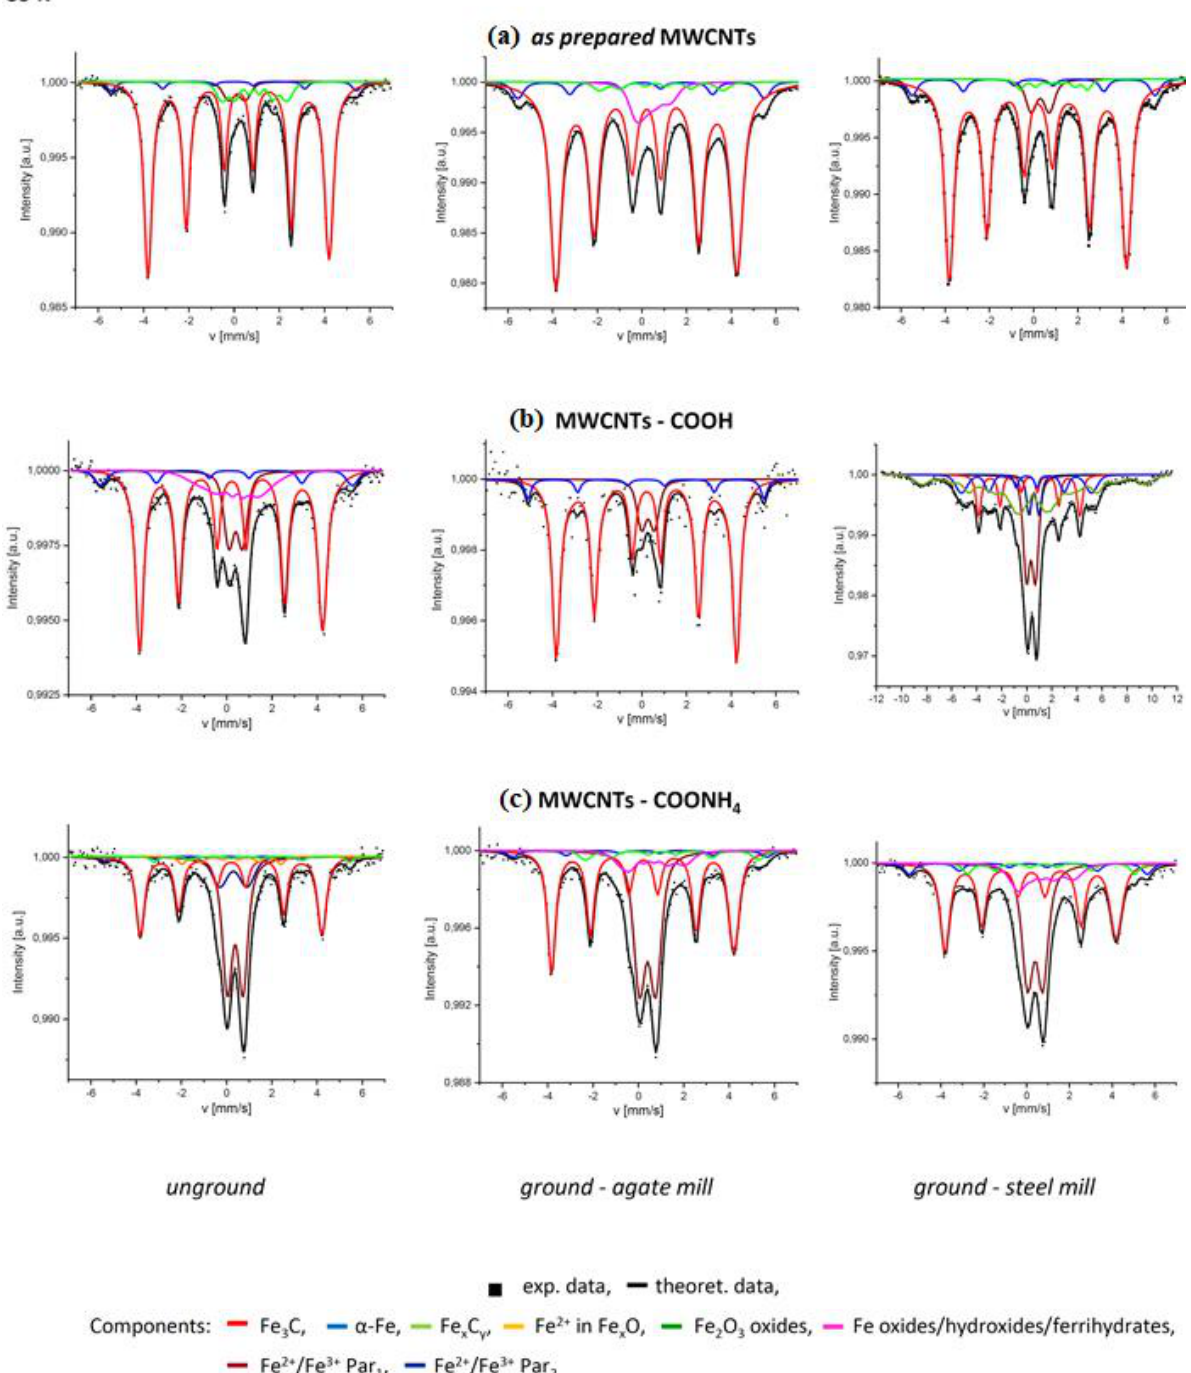
Figure 2. Mössbauer spectra for ( a ) as prepared MWCNTs, ( b ) MWCNTs-COOH, and ( c ) MWCNTs-COONH 4 : left column — the control group, middle column — after using the agate mill, right column — after using the steel mill, all measured at 85 K. In the case of MWCNTs-COOH treated by a steel mill (b — right column), we applied a wider velocity scale due to the presence of the magnetically ordered iron oxide phase with a high hyperfine magnetic field.